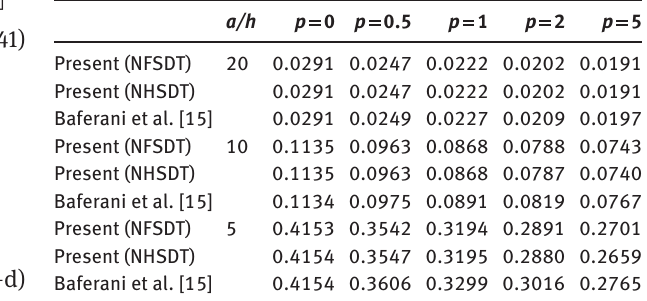
Table 2: Comparison study of the nondimensional fundamental frequency parameter ω ′ = K = K w s